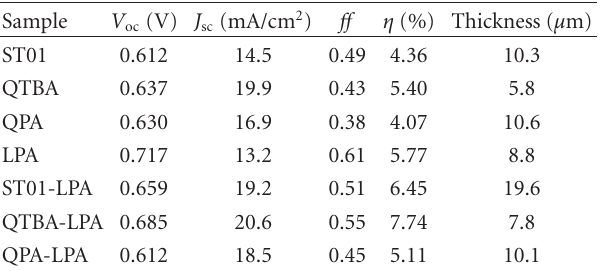
Table 2: Photovoltaic parameters of DSCs fabricated using the TiO 2 nanocrystals and thickness of the TiO 2 nanocrystals films. Sample